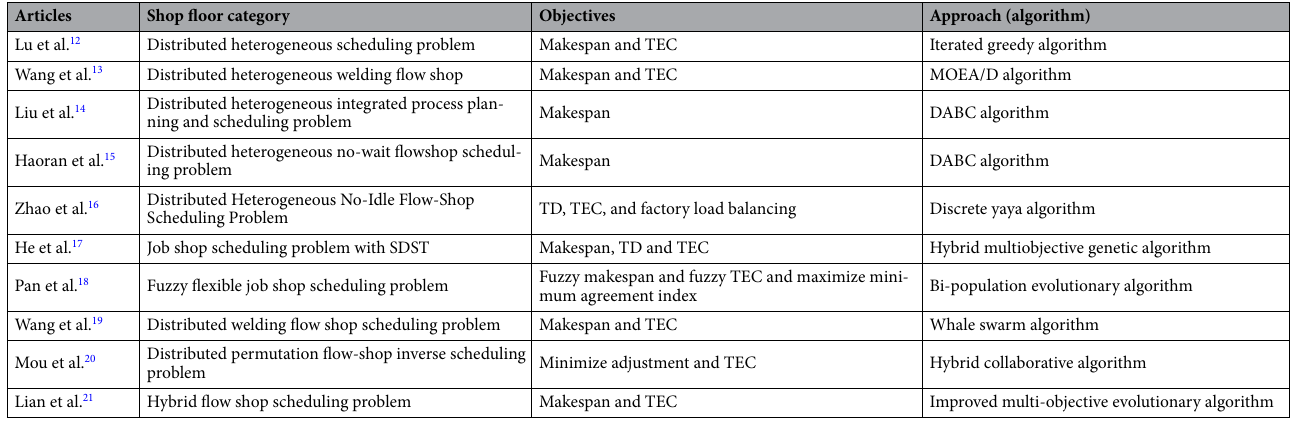
Table 1. Literatures